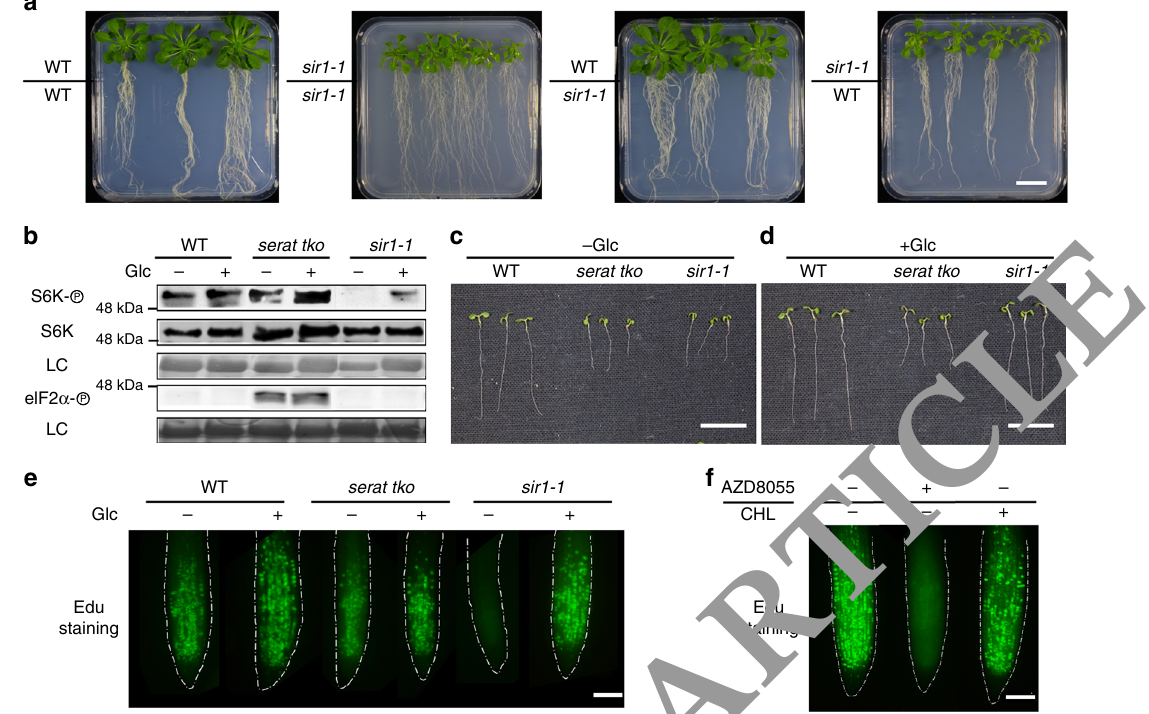
Fig. 4 Sulfur availability regulates root meristem and plant growth via glucose-TOR. a Phenotype of chimeric plants obtained by grafting of wild-type (WT) and sir1-1 organs. Identity of organs is depicted as shoot/root. Scale bar, 2 cm. b – e Feeding of serat tko and sir1-1 seedlings with glucose. b Immunological detection of S6K-p, S6K (apparent sizes: 52 kDa), and eIF2 α -p (apparent size: 43 kDa) with speci fi c antisera in wild-type serat tko and sir1-1 . c , d Phenotype of wild-type serat tko and sir1-1 plants in the absence and presence of glucose. Scale bar, 1 cm. e Impact of glucose on root meristem activity in wild-type serat tko and sir1-1 . Scale bar, 25 µ m. f Root meristem activity of 7-day-old WT seedlings treated with TOR inhibitor (AZD-8055) or GCN2 activator (Chlorosulfuron, CHL) for 2 h. Scale bar, 25 µ